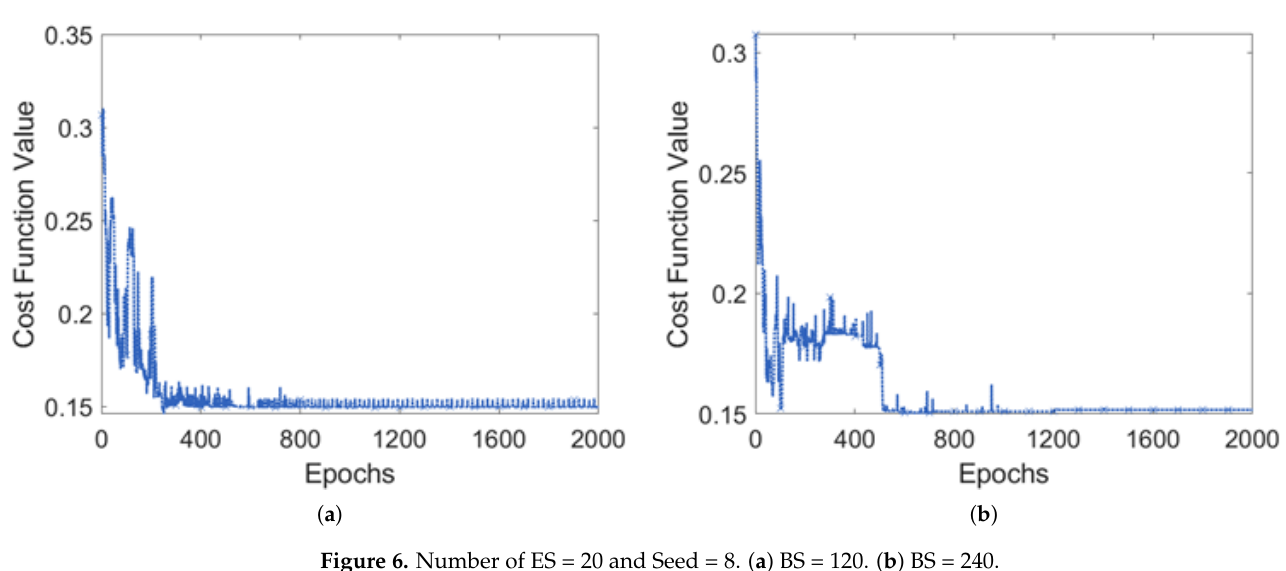
Figure 6. Number of ES = 20 and Seed = 8. ( a ) BS = 120. ( b ) BS = 240. C. Is the proposed solution effective in finding the best placement for mobile edge servers when the number of mobile edge servers present in the network is varied?